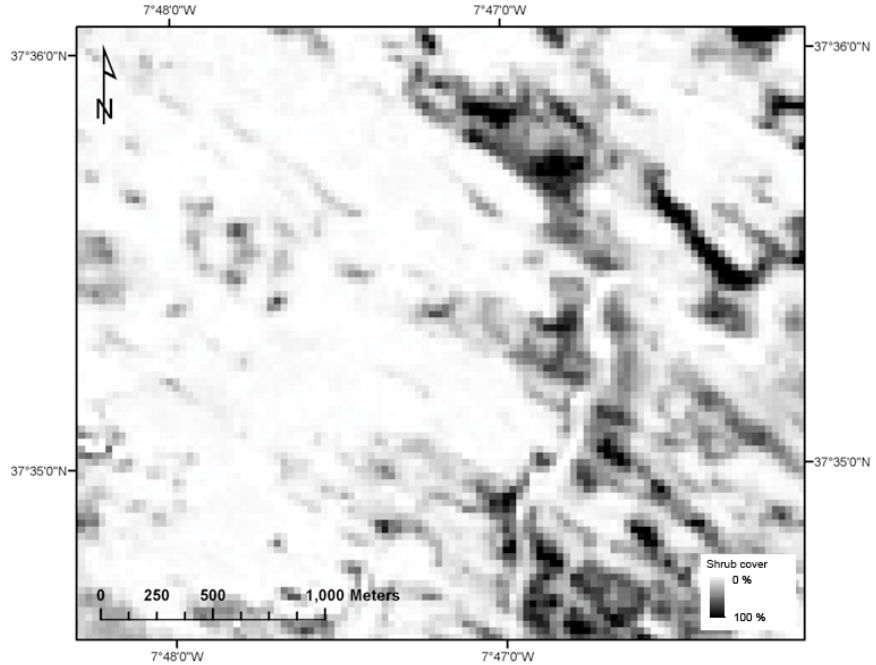
Figure 3. Spatial gradients of shrub cover, as derived from the land cover map of the study area resampled to a ground sample distance (g.s.d.) of 30 m (adapted from [43]). In this image, brighter pixels correspond to areas with low shrub cover, and darker ones correspond to areas with higher (successional) shrub cover. The gradual transitions from bright to dark pixels illustrate the described vegetation